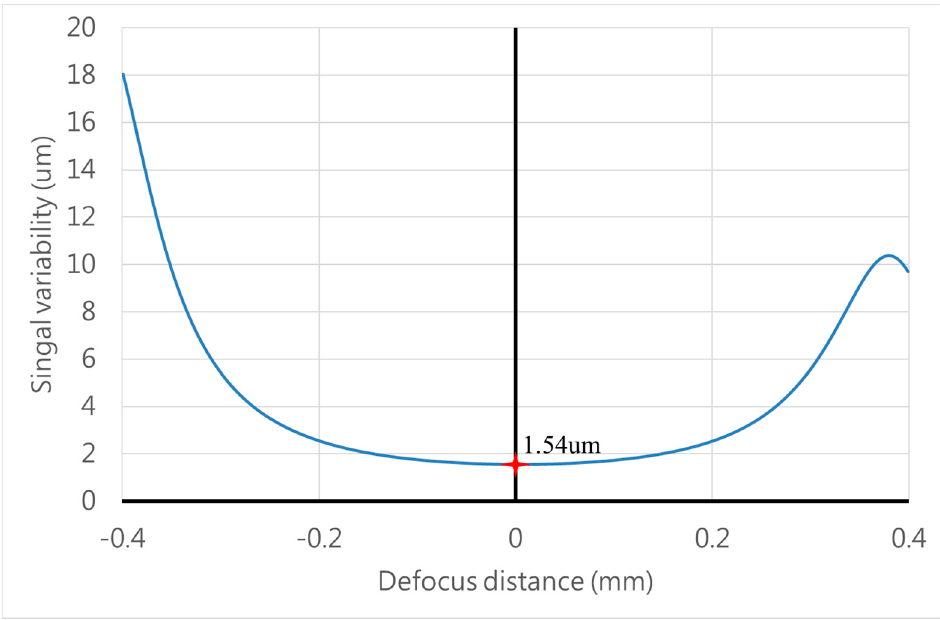
Figure 7. The distribution of signal variability versus defocus distance.